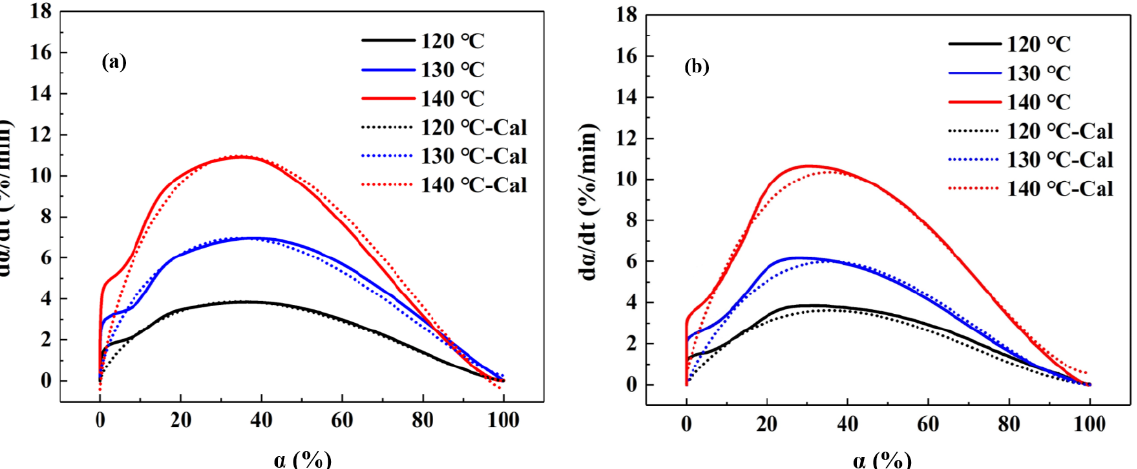
Figure 2. Curves of the relationships between d α /dt and α , and comparison between the tested and calculated data: ( a ) unfilled matrix resin; ( b ) Ag-filled ICA. Table 3. Data obtained from the relationship between d α /dt and α as obtained in tests.